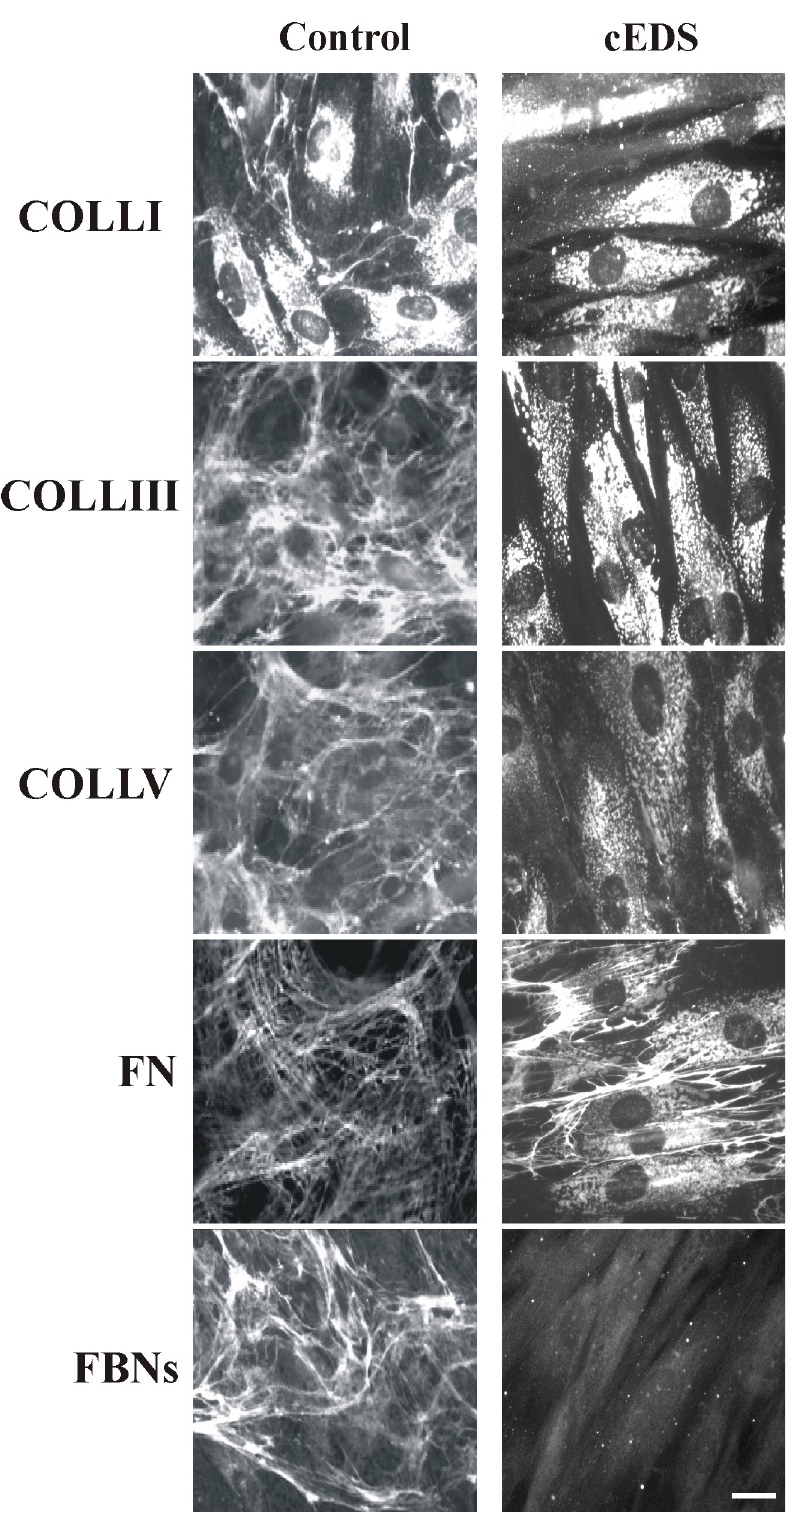
Fig 4. cEDS patients’ skin fibroblasts show the altered deposition of different structural components into the ECM. Control and patients’ cells were analyzed with specific Abs directed against COLLI, COLLIII, COLLV, FN, and FBNs. FN and FBNs were investigated by labeling the cells with Abs recognizing all their isoforms. Images are representative of 4 control and 4 cEDS cell strains. Scale bar: 10 μ m. https://doi.org/10.1371/journal.pone.0211647.g004 PLOS ONE | https://doi.org/10.1371/journal.pone.0211647 February 4,